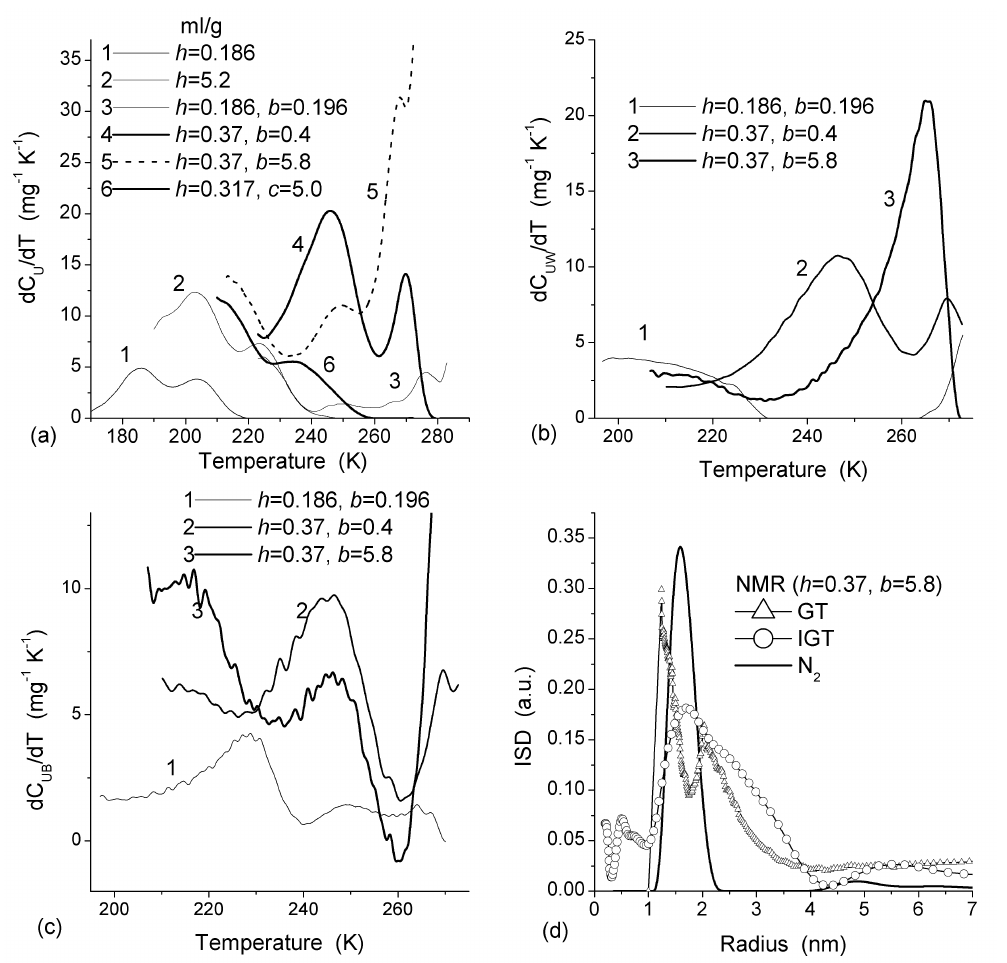
Fig. 15 Derivative dC u / dT as a function of temperature at different amounts of water, benzene and chloroform- d (sample 2) for (a) total amounts of water or water/benzene; (b) water and (c) benzene adsorbed onto MCM-41; and (d) IPSD calculated on the basis of the nitrogen adsorption isotherm and ISD for water/benzene adsorbed onto MCM-41 (using GT and IGT